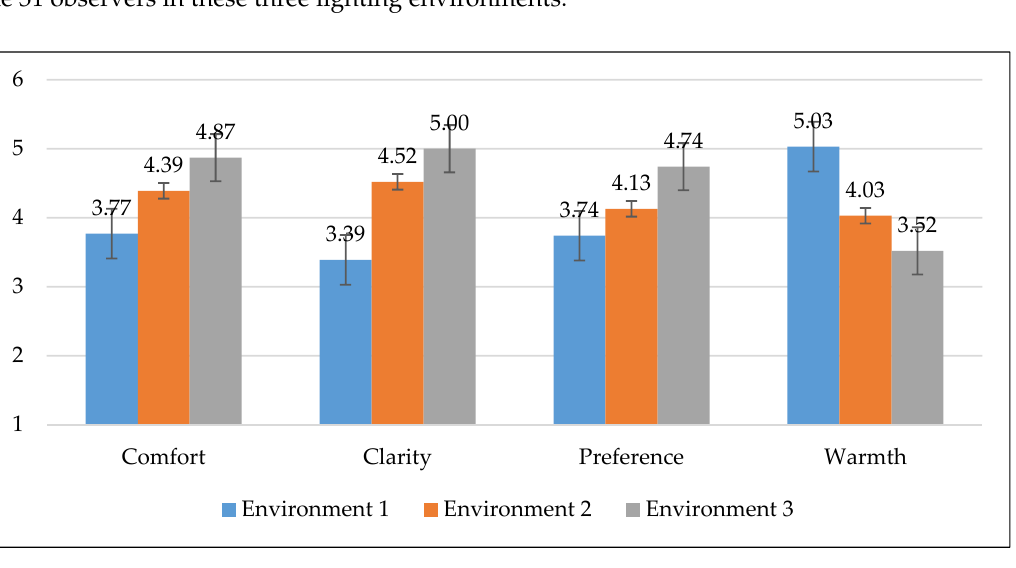
Figure 13. Mean value of four psychological perceptions in different environments (Environment 1 is the national museum of western art. Environment 2 is the Aichi Prefectural museum of art. Environment 3 is the Yamazaki Mazak museum of art).